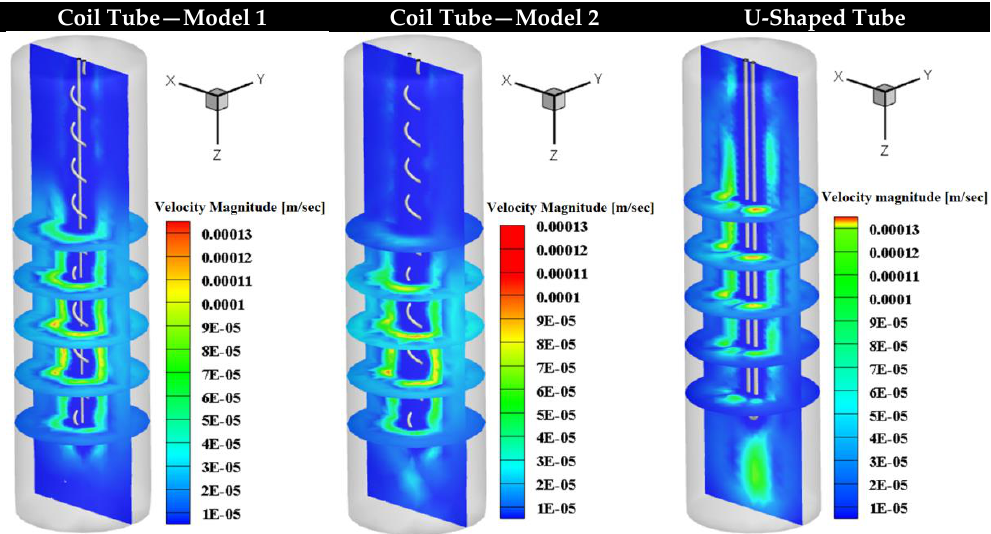
Figure 14. Three-dimensional contours of the velocity magnitude (m/s) for the three models.